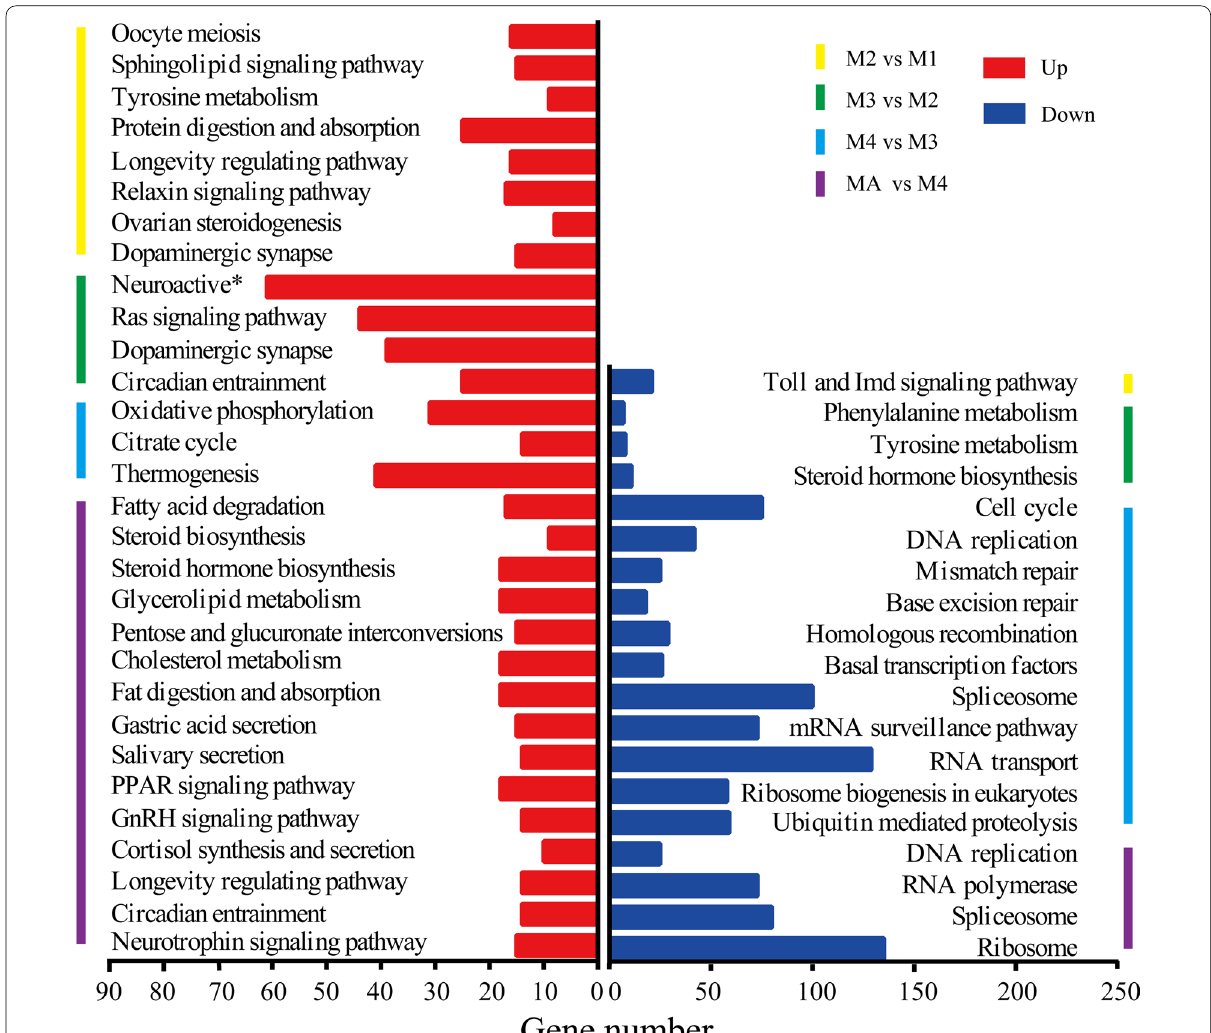
Fig. 8 Significantly enriched KEGG signaling pathways of differentially expressed genes derived from pairwise comparison of M2 vs. M1, M3 vs. M2, M4 vs. M3, and MA vs. M4. Significantly enriched pathways were determined at adjusted P < 0.05 through the hypergeometric